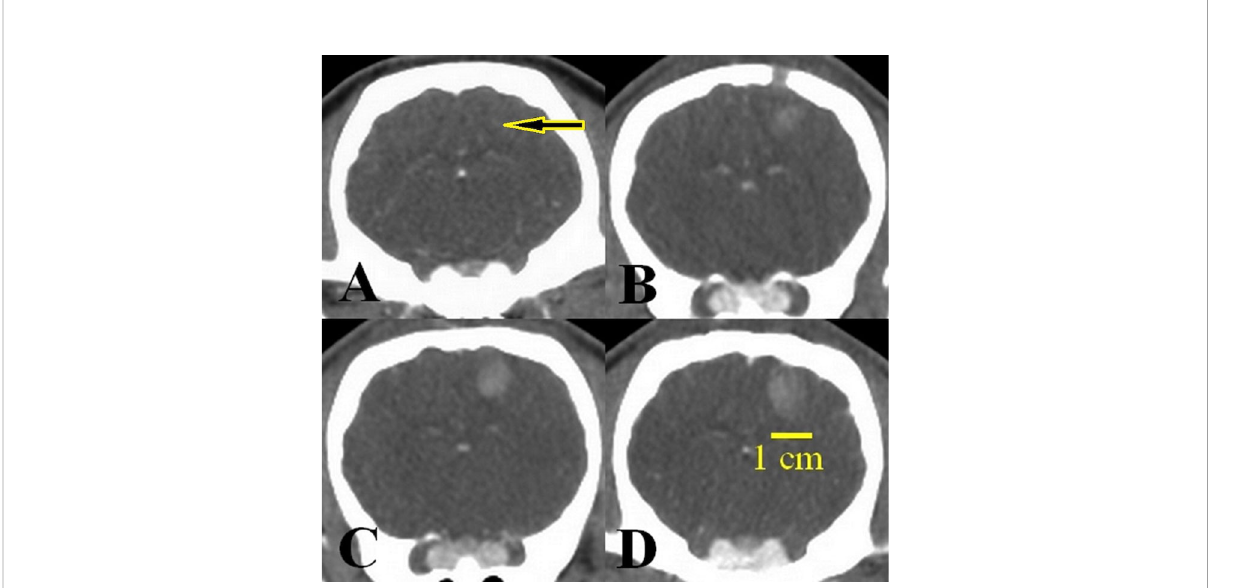
FIGURE 1 Tumor growth over 14 days post-implantation of the U87 cell line. (A) Cell implantation area (arrow) at day 0, (B) tumor size 4 mm, 7 days after implantation, (C) tumor size 7 mm, 10 days after implantation, (D) tumor size 13 mm, 14 days after implantation, just before injection of the Ho